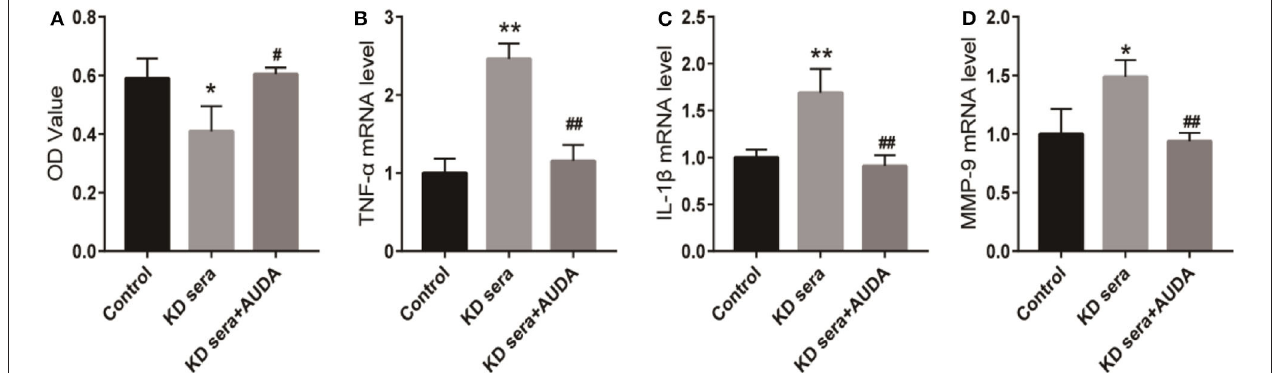
FIGURE 2 | AUDA blocked the inflammatory response induced by KD sera in HCAECs. HCAECs were cultured with 10% KD sera (KD sera group) with cells in conventional culture as the control group. KD sera group cells were treated with 100 µ mol/L AUDA to generate the KD sera + AUDA group. (A) The proliferation of HCAECs in each group was detected by CCK-8. The mRNA levels of TNF- α (B) , IL-1 β (C) , and MMP-9 (D) in each group were detected using qPCR. * P < 0.05 vs. control; ** P < 0.01 vs. control; # P < 0.05 vs. KD sera; ## P < 0.01 vs. KD